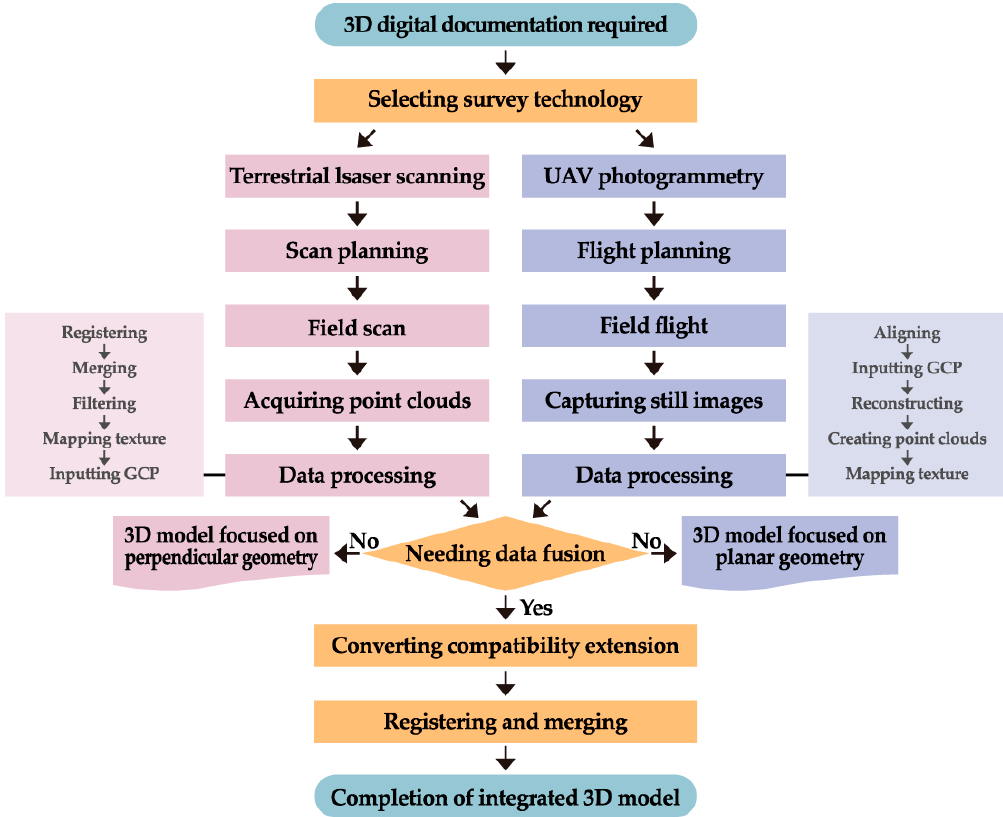
Figure 11. Workflow of integrated 3D modeling using terrestrial laser scanning and UAV photogrammetry.